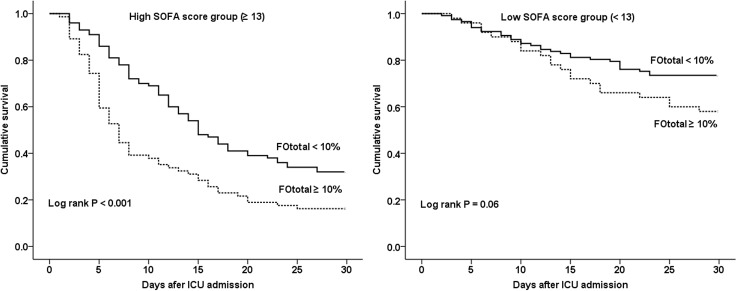
Kaplan-Meier survival estimate %FOtotal ≥ 10% or < 10% in the high SOFA score group (≥ 13, n = 174) and in the low SOFA score group (< 13, n = 167).In the high SOFA score group, there was a significant difference in survival among patients with %FOtotal ≥ 10% or < 10% (P < 0.001). However, in the low SOFA score group, there was no difference in survival (P = 0.06). %FOtotal = percentage of total fluid overload from baseline body weight from 3 days before CRRT initiation to ICU discharge. ICU = intensive care unit.